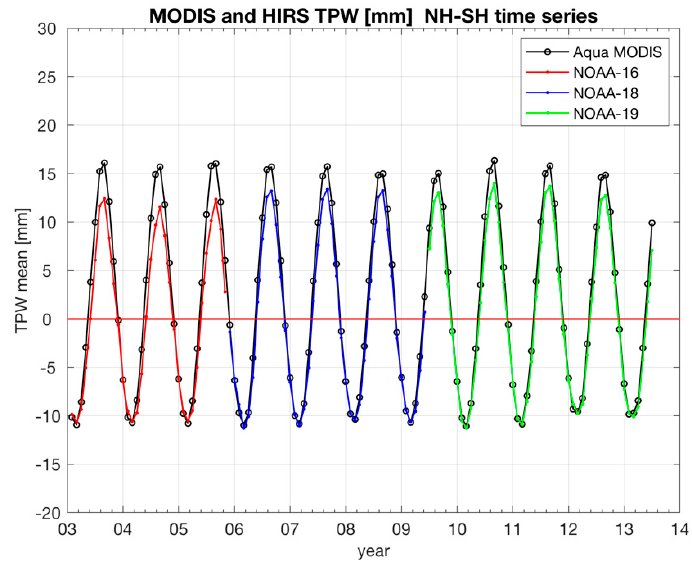
Figure 7. HIRS and MODIS northern (60 ◦ N to Equator) minus southern (Equator to 60 ◦ S) hemispheric mean TPW by month from 2003 to 2014.